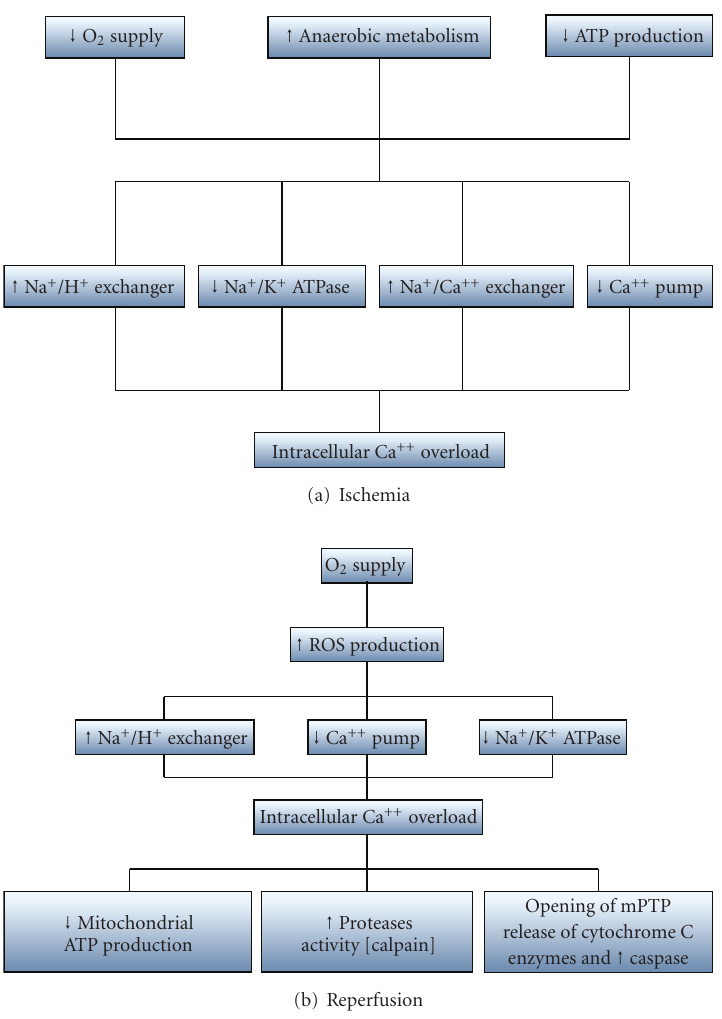
Figure 3: (a, b) Pathophysiological consequences of (a) ischemia and (b) reperfusion. (mPTP, mitochondrial permeability transition pore).